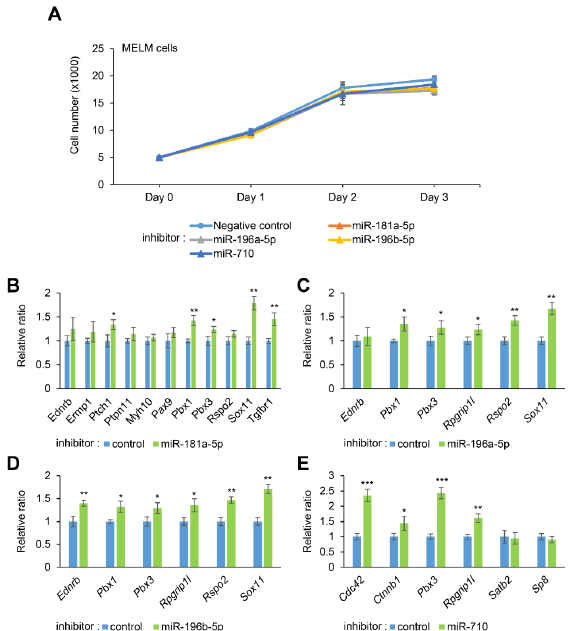
Figure 2. Effect of inhibition of miR-181a-5p, miR-196a-5p, miR-196b-5p, or miR-710 on proliferation of mouse embryonic lip mesenchymal (MELM) cells. ( A ) Cell proliferation assays in primary MELM cells treated with control, miR-181a-5p, miR-196a-5p, miR-196b-5p, or miR-710 inhibitor. ( B – E ) Quantitative RT-PCR for the indicated genes after treatment of primary MELM cells with control or miR-181a-5p inhibitor ( B ), miR-196a- inhibitor ( C ), miR-196b-5p inhibitor ( D ), and miR-710 inhibitor ( E ). * p < 0.05, ** p < 0.01, *** p < 0.001 versus control ( n =